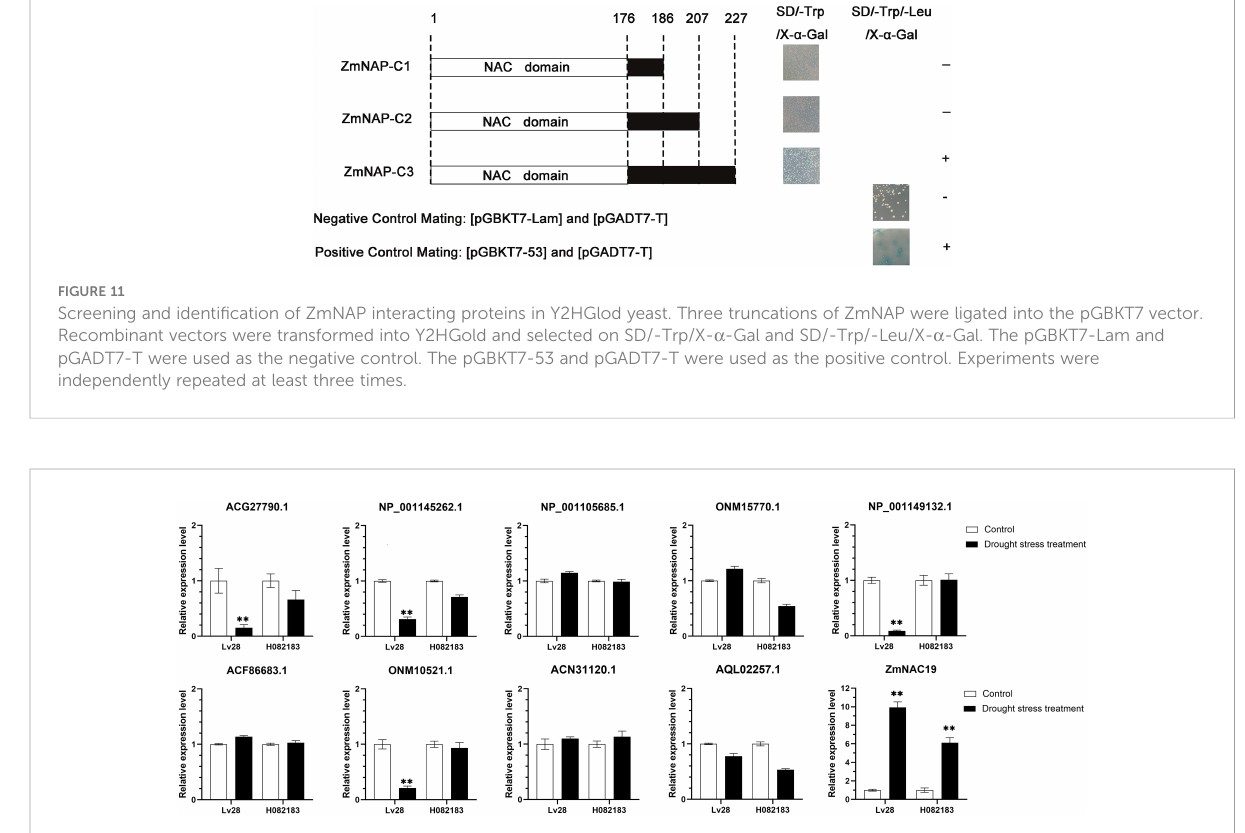
FIGURE 12 Expression analysis of ZmNAP interacting protein coding genes under drought stress in Lv28 and H082183. Maize ZmGAPDH (NM_001111943) was used as the internal reference gene. Highly signi fi cant differences (P < 0.01) were represented by